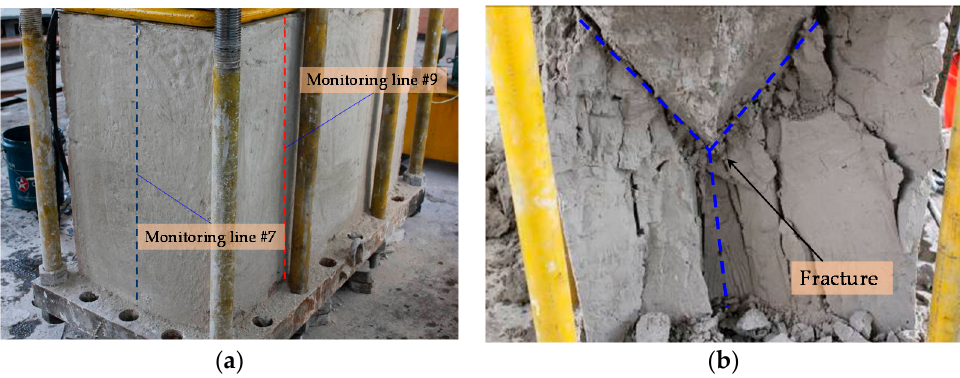
Figure 7. Loading and destruction process of large-size specimen. ( a ) Specimen without damage; ( b ) Totally destroyed.